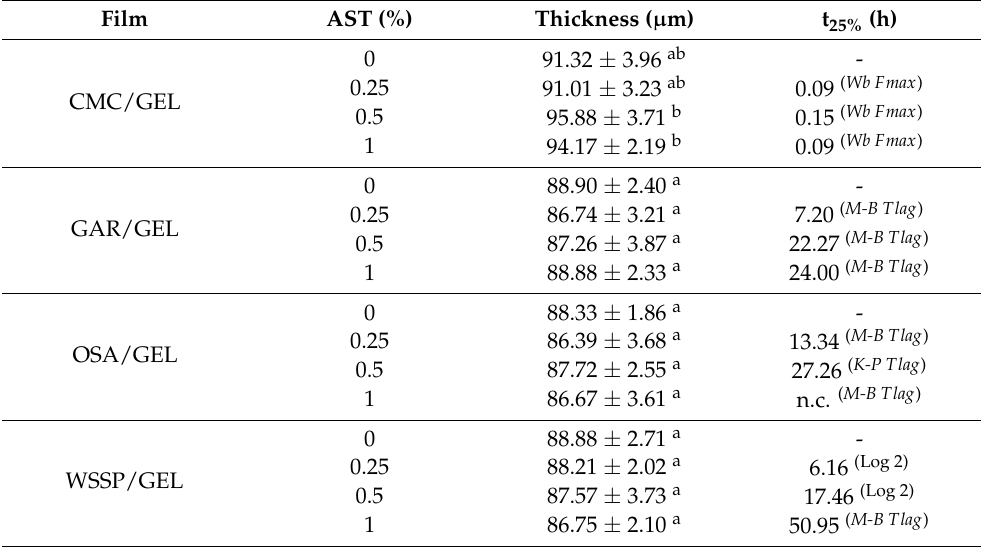
Figure 2. Images of AstaSana powder ( A ) and the dehydrated AstaSana aqueous solution exam- ined using the scanning electron microscopy ( B ). The aqueous solution of AstaSana examined us- ing the optical microscopy ( C ).